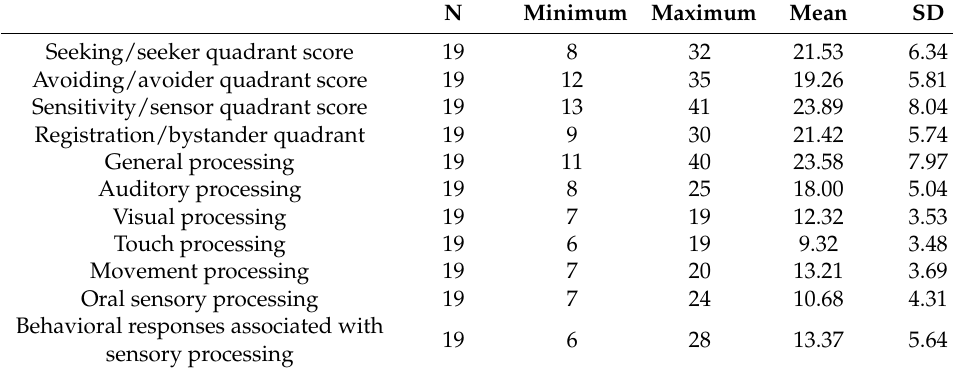
Table 5. Toddler sensory